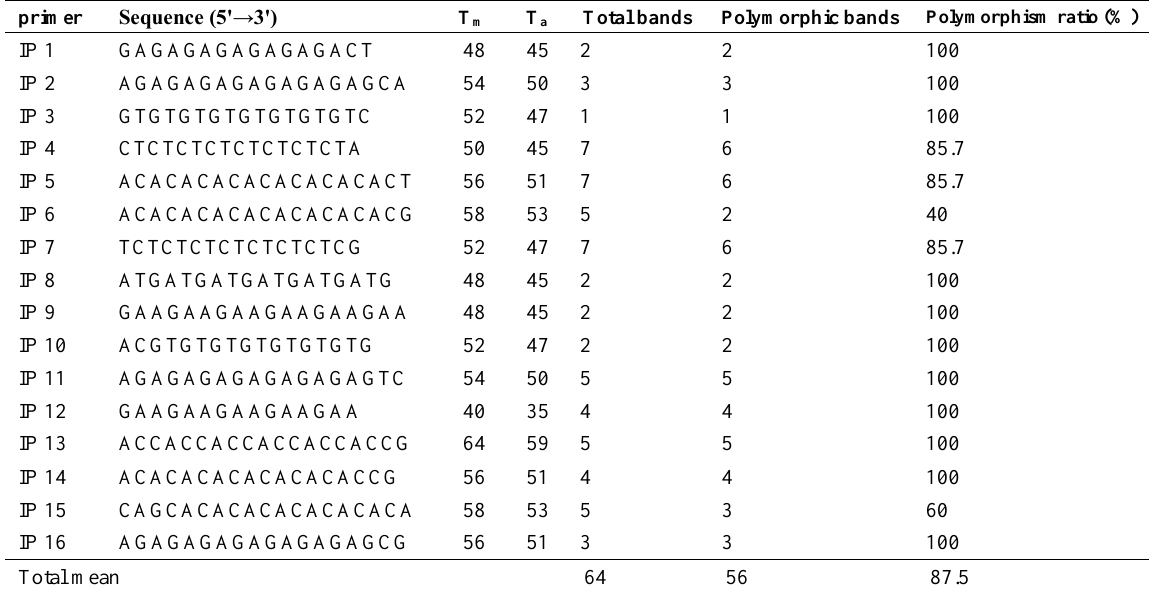
Table 4. List of ISSR primers along with their sequences, T m , T a , the number of polymorphic and total bands resultant from all tested wheat genotypes.